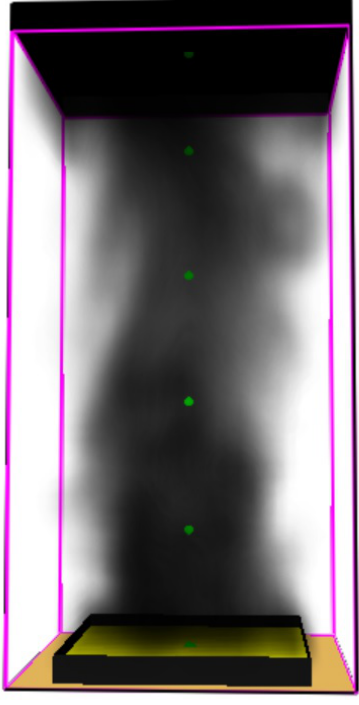
Figure 20. Soot mass fraction field at t = 80.5 s.